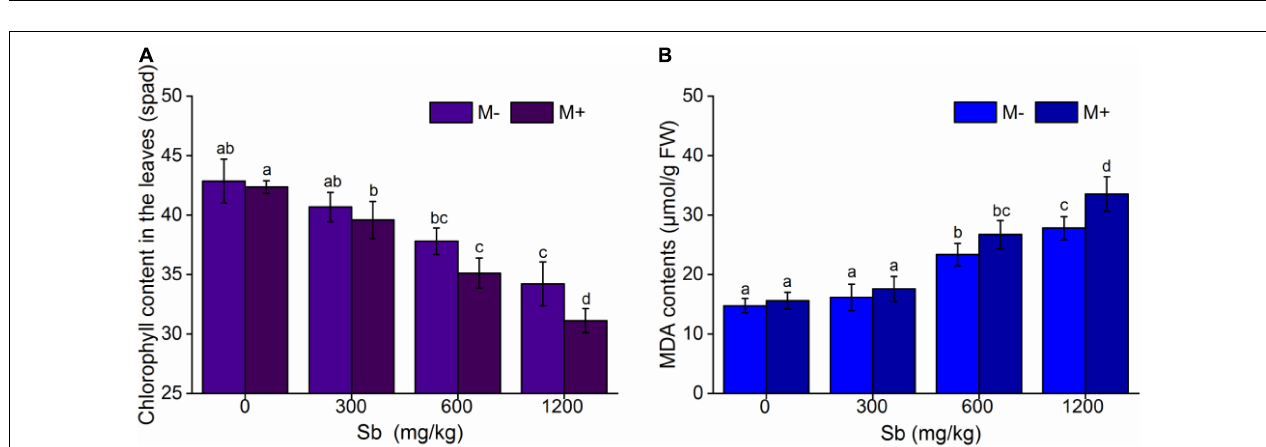
FIGURE 2 | Microstructure of arbuscular mycorrhizal fungi infect the root of rice. (A,B) Vesicle in roots of arbuscular mycorrhizal fungi, (C,D) hypha of arbuscular mycorrhizal fungi in roots. ve represents vesicle, hy represents hypha.